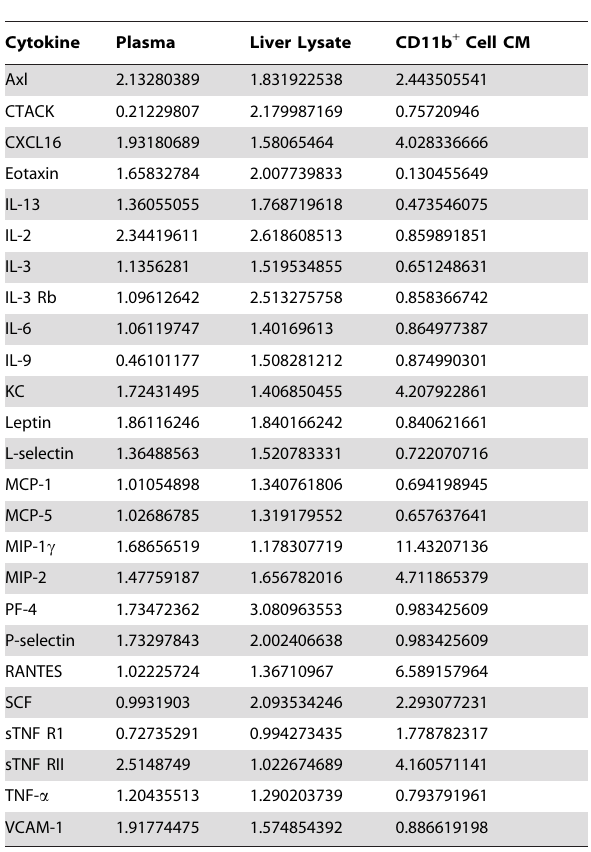
Plasma, liver tissue lysates and conditioned media from CD11b + magnetically isolated cells Cytokine arrays were used to detect changes in cytokine levels in the plasma, perfused liver tissue lysate (Liver Lysate), and from conditioned media of isolated CD45 + CD11b + subpopulations (CD11b + Cell CM) between normal and steatotic samples. Cytokine values are presented as fold change with values greater than 1 representing increased levels and values less than 1 representing decreased levels in steatotic samples. (n=3). Axl (Tyrosine protein kinase 7), CTACK (Cutaneous T-cell attracting chemokine, CCL27), CXCL16 (CXC chemokine ligand 16), IL-2 (Interleukin-2), IL-3 (Interleukin-3), IL-6 (Interleukin-6), IL-9 (Interleukin-9), IL-13 (Interleukin-13), IL-3 Rb (Interleukin-3 receptor